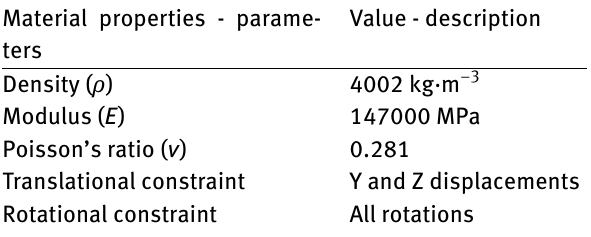
Figure 2: Example of designed rock geometry according to a 2 nd polynomial expression with constant y – radius. Table 2: Material properties of the selected